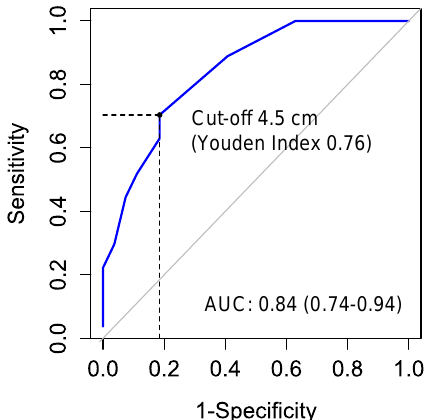
Figure 2. Receiver operating characteristics curve for rupture length and all-cause mortality. (Area under the curve (AUC), 0.84 (95% CI 0.74–94)). The cutoff length was identified as 4.5 cm with a